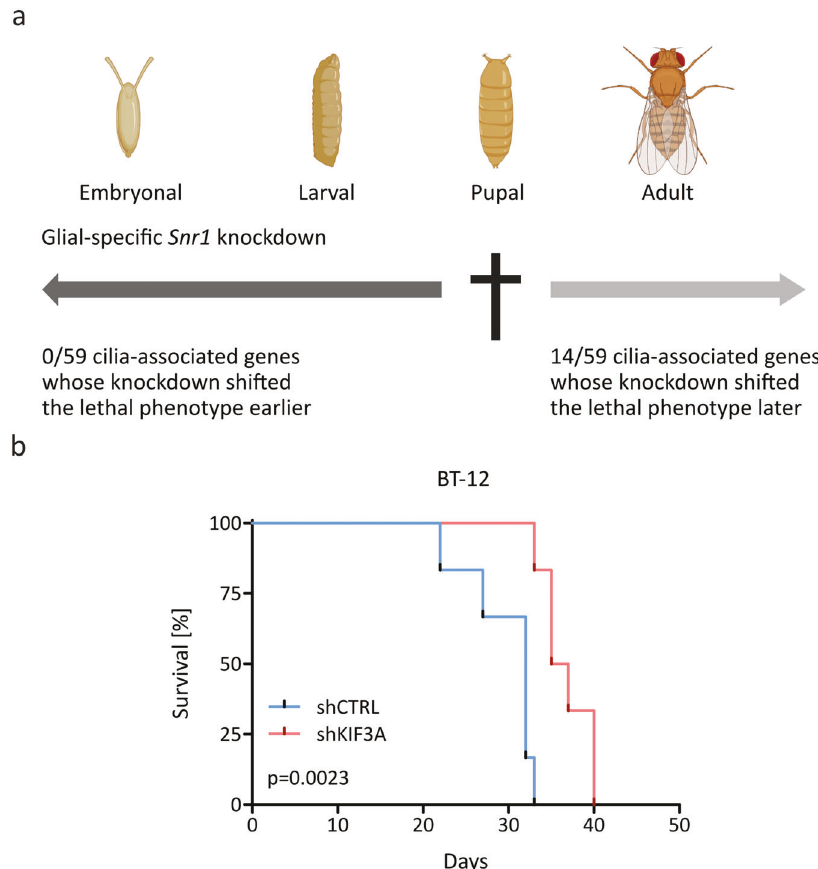
Fig. 6 Primary ciliogenesis contributes to AT/RT biology in vivo. a Crossing of Snf5 ‐ related 1 ( Snr1 ) knockdown fl ies with strains expressing speci fi c RNA interference (RNAi) shifted the pupal lethal phenotype associated with glial ‐ speci fi c Snr1 knockdown to later stages of development in 14 out of 59 screened candidate genes. The complete list of the 59 genes is shown in Supplementary Table 8. Created with BioRender.com. b Kaplan ‐ Meier survival curve of NOD scid gamma (NSG) mice orthotopically injected with control BT ‐ 12 cells ( n = 6, shCTRL, blue) or KIF3A knockdown BT ‐ 12 cells ( n = 6, shKIF3A, red). Statistical analysis was performed using the Gehan ‐ Breslow ‐ Wilcoxon